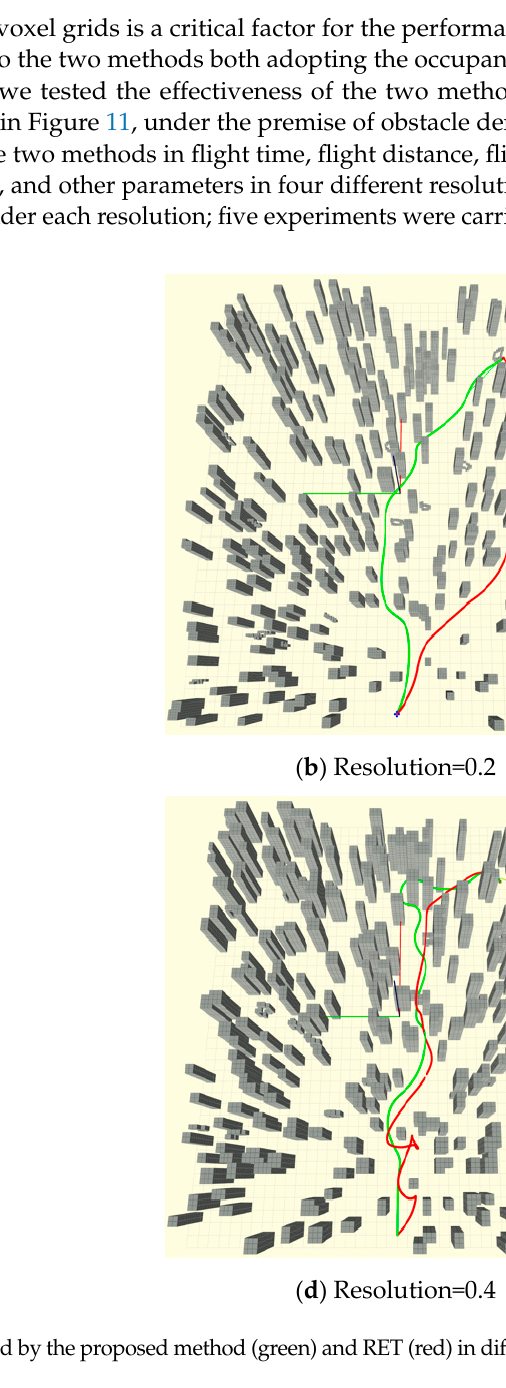
Table 2. The comparisons of two planning method.